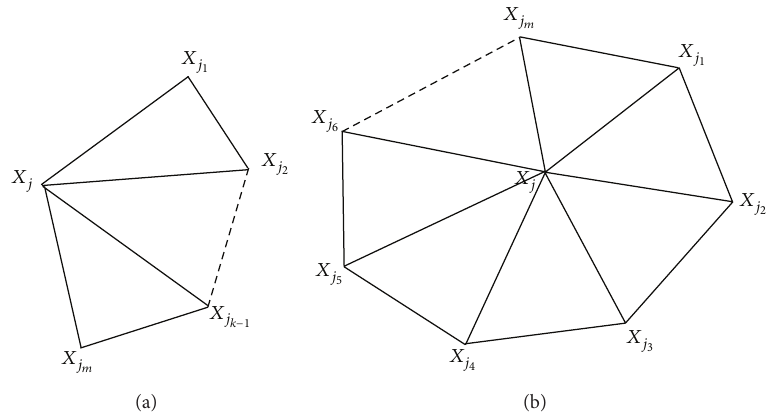
Figure 3: The local radial basis interpolation point set 𝐴 𝑗 around point 𝑋 𝑗 , (a) 𝑋 𝑗 is a boundary point of 𝑇 and (b) 𝑋 𝑗 is an interior node point of 𝑇 .